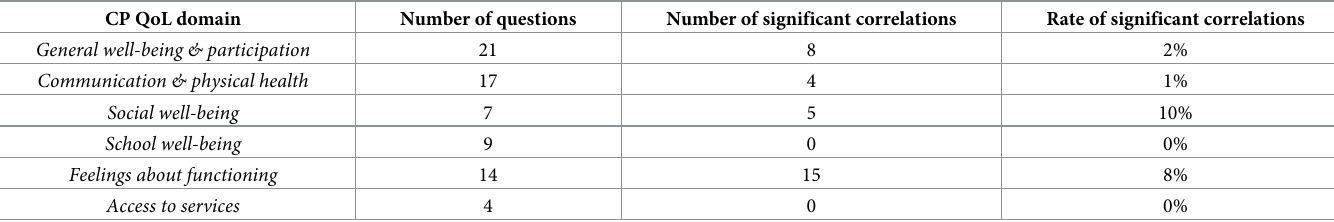
Table 5. Differences between adolescents’ domains from Hungary and Pannonian-based